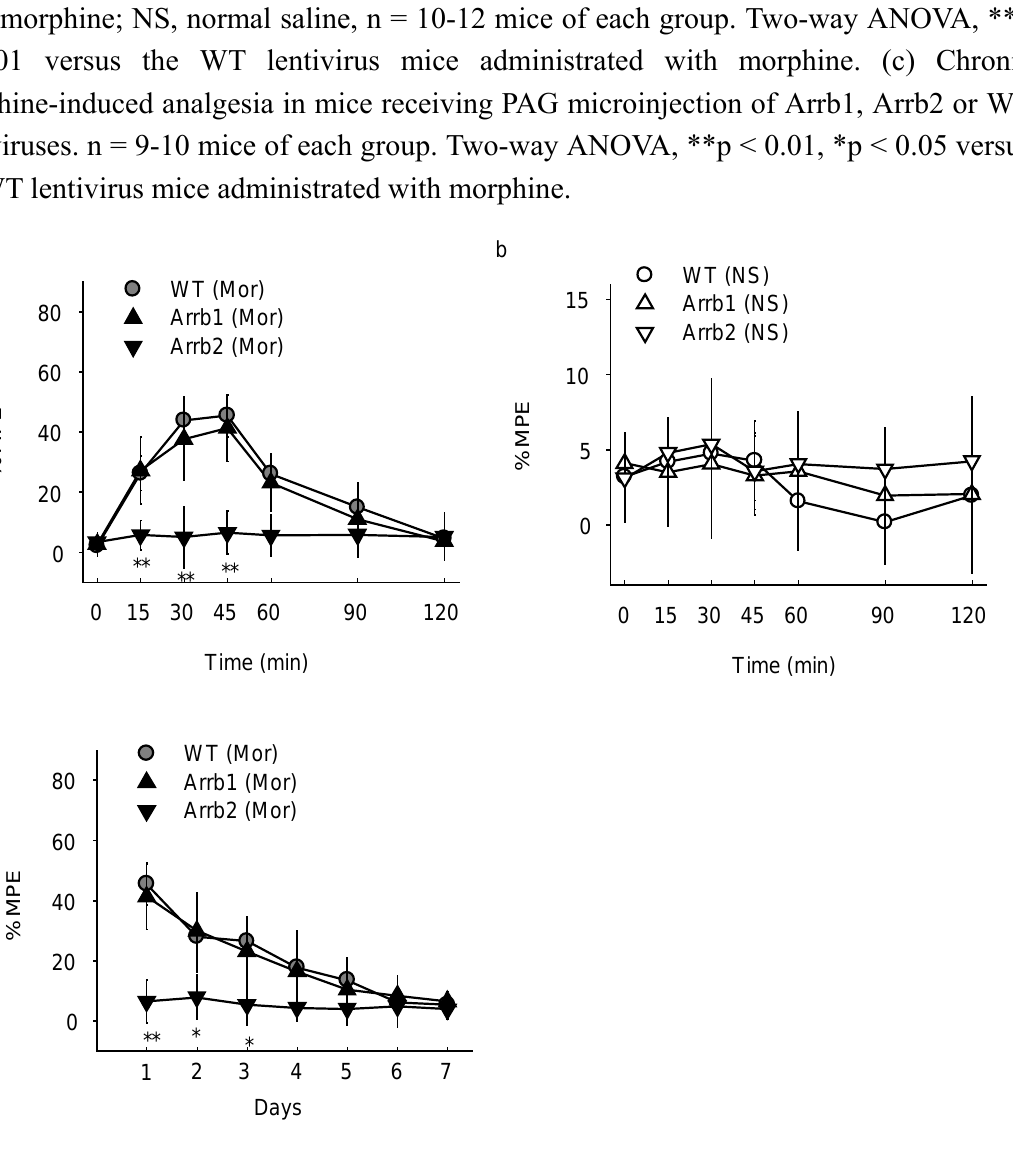
Figure 3. (a and b) Acute morphine analgesia in mice receiving PAG microinjection of GFP tagged β -arrestin 1 (Arrb1), β -arrestin 2 (Arrb2) or GFP control (WT)